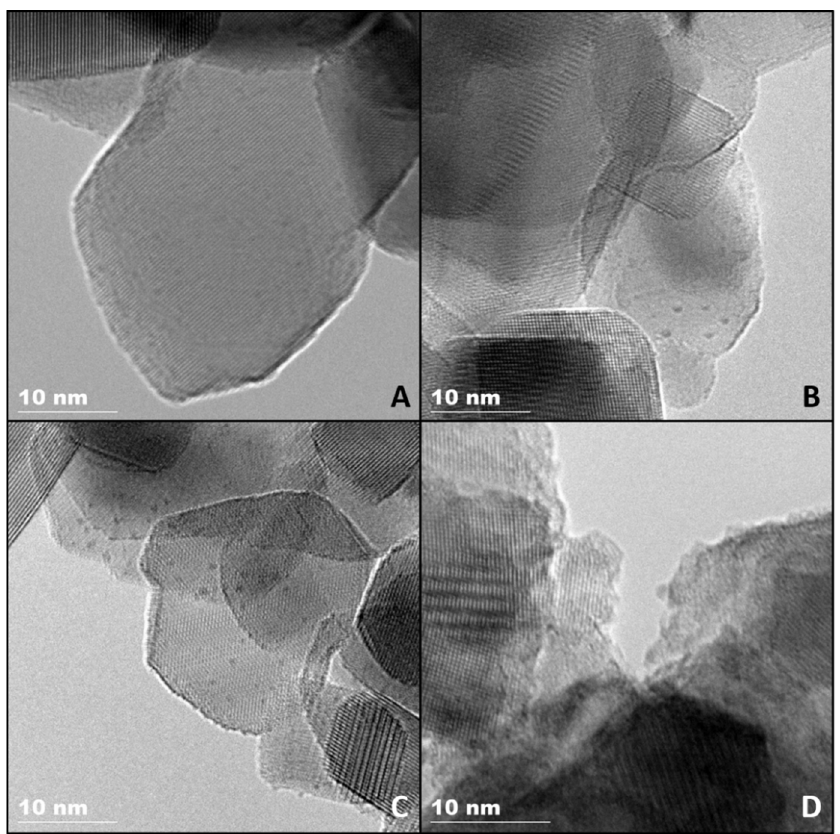
Figure 2. Example TEM images of Ru-14 ( A ), Ru-28 ( B ), Ru-41 ( C ) and Ru-70 ( D ).